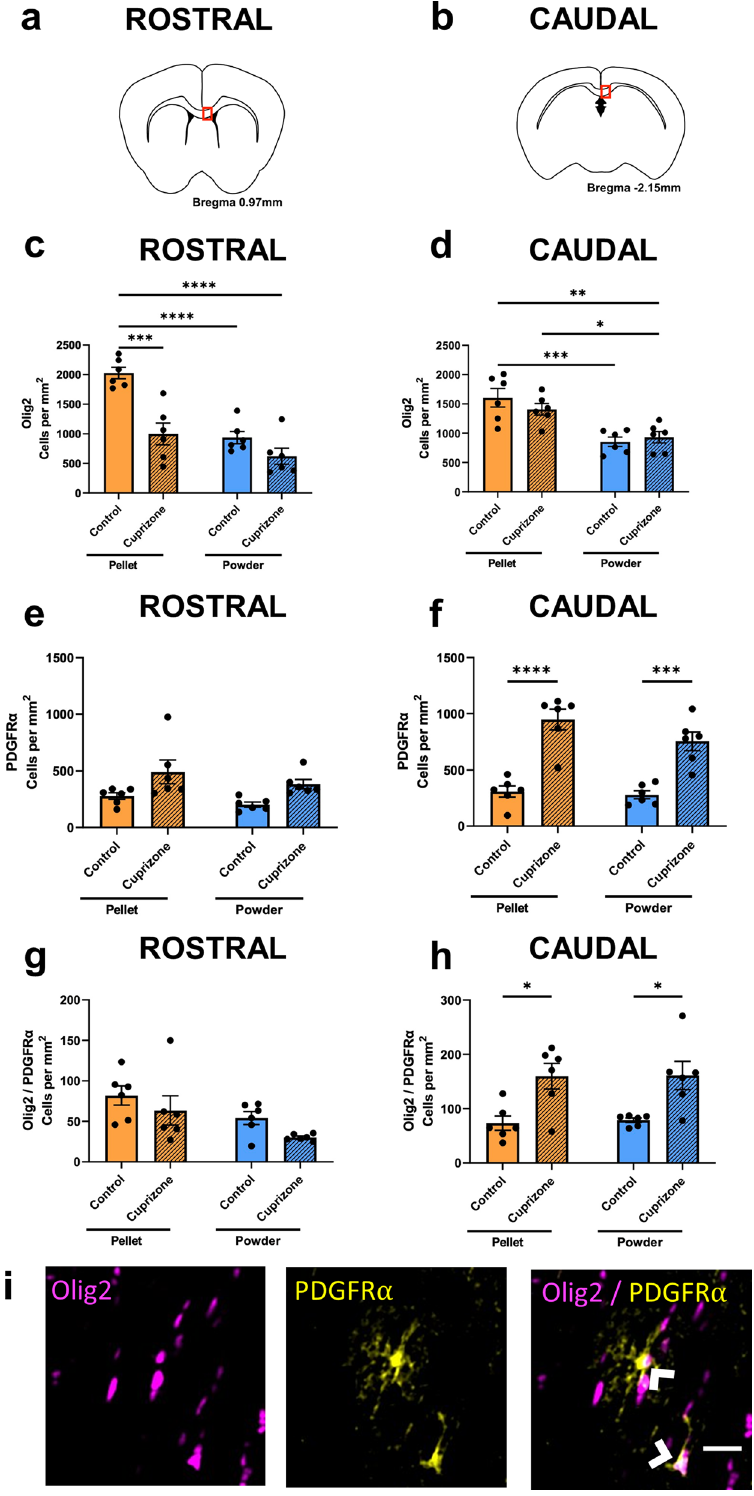
Figure 5. Effects of cuprizone feed formulation on densities of Olig2+, PDGFRα+ and Olig2+/PDGFRα+ cells. The area of the rostral and caudal corpus callosum analysed is denoted by the red box in the coronal illustrations of the brain ( a , b ). The density of Olig2+ cells ( c , d ), PDGFRα+ cells ( e , f ) and Olig2+/PDGFRα+ cells ( g , h ) were quantified in the rostral and caudal corpus callosum. N = 6 mice per group, graphs display individual data points overlayed on a bar displaying the mean ± SEM. Significant differences are indicated by *p ≤ 0.05, **p ≤ 0.01, ***p ≤ 0.001, ****p ≤ 0.0001. ( i ) Representative images of Olig2+, PDGFRα+ and Olig2+/PDGFRα+ cells, indicated with arrow heads; scale bar = 25